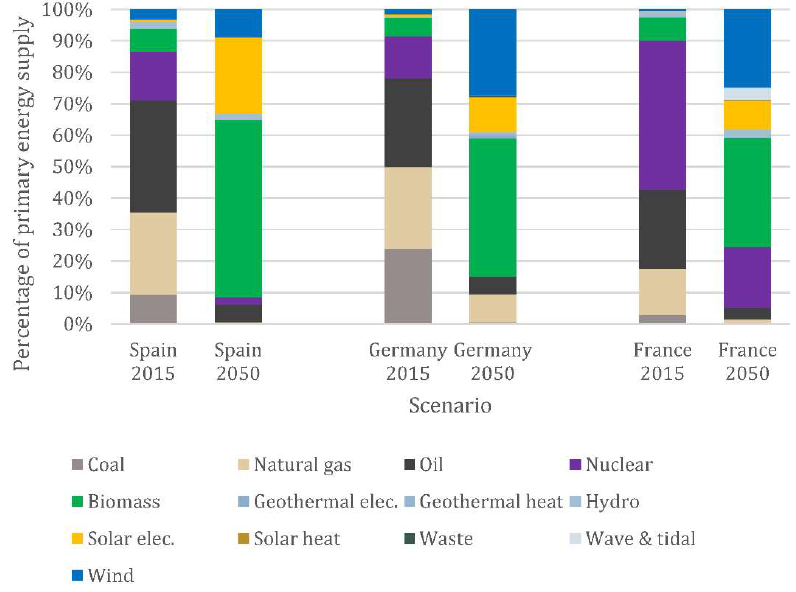
Figure 3. Primary energy supply in the Heat Roadmap Europe scenarios for Spain, Germany, and France [40].